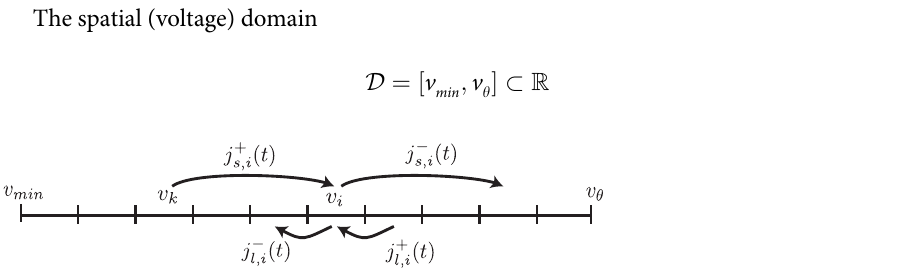
Fig 2. Illustration of probability mass flux. Assuming a single excitatory input with weight w = v i − v k , at time t subdomain v i has two sources j þ ð t Þ and j þ ð t Þ of probability mass in fl ux, and two out fl ow destinations ð s ; i Þ ð l ; i Þ j (cid:2) ð t Þ and j (cid:2) ð t Þ . As Δ t ! 0, these fl uxes are linear in the probabilities at each node p i (Eqs 9 – ð s ; i Þ ð l ; i Þ